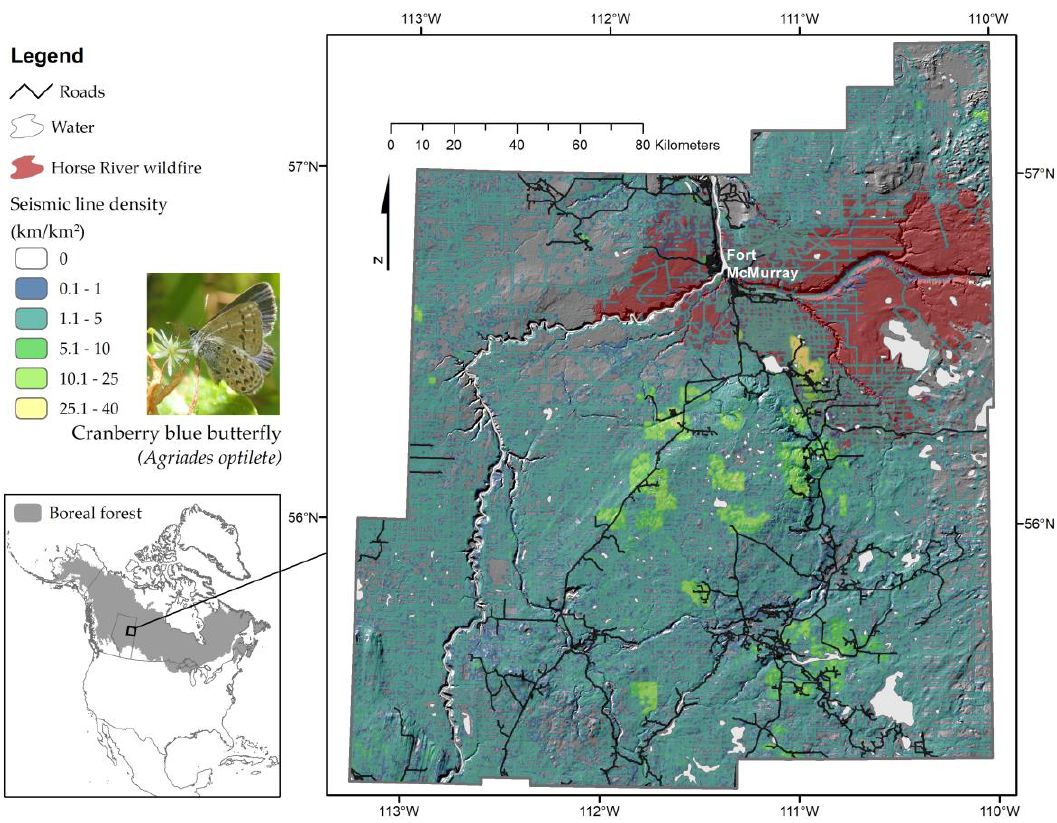
Figure 1. Cranberry blue butterfly ( Agriades optilete ) nectaring on chickweed ( Stellaria longifolia ), and map of the study area, encompassing ~40,000 km 2 of the Wood Buffalo Region of northeastern Alberta. These forests show a high degree of forest fragmentation due to seismic lines (3–10 m wide forest clearings) used for seismic assessments of the underground oil sands reserve, as well as a recent ~6000 km 2 wildfire (2016 Horse River wildfire) near the Town of Fort McMurray. Photograph by F. Riva.